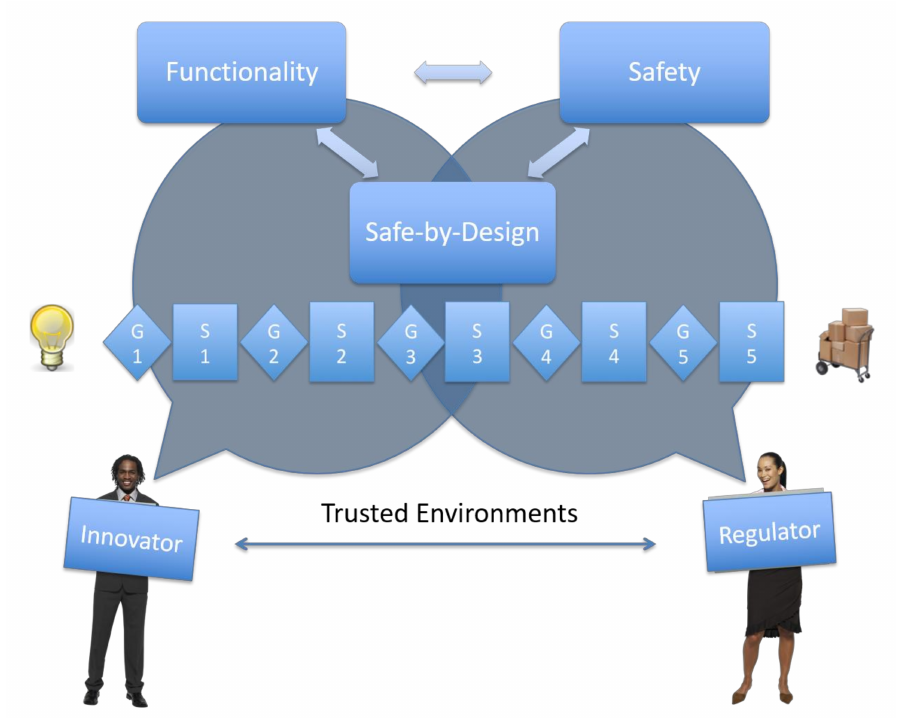
Figure 4. Integrated overview of the relationships between Innovators and Regulators in the Safe-by-Design and Trusted Environment system. Safe-by-Design addresses both Functionality and Safety, while Trusted Environments are the safe lines of communication between the two parts. G: Gates, S: